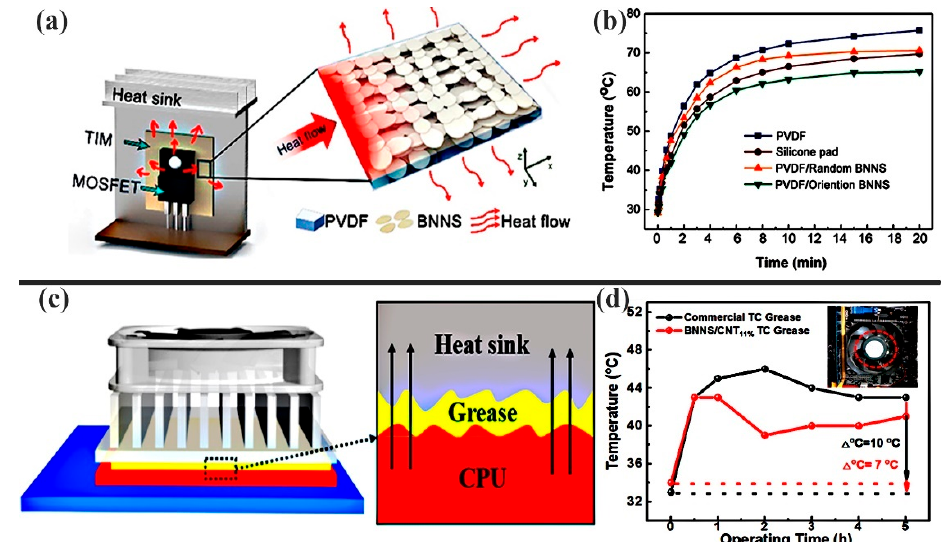
Figure 31. ( a ) Schematic diagram of a metal–oxide–semiconductor field-effect transistor (MOSFET) integrated with TIMs. ( b ) The surface temperature variations of MOSFETs versus time (reproduced with permission from [215]). ( c ) Illustrating heat dissipation measured along the grease filled with BNNS/CNT11%. ( d ) The comparison for heat dissipation effect between the nanocomposites film and commercial TC grease (reproduced with permission from [216]).